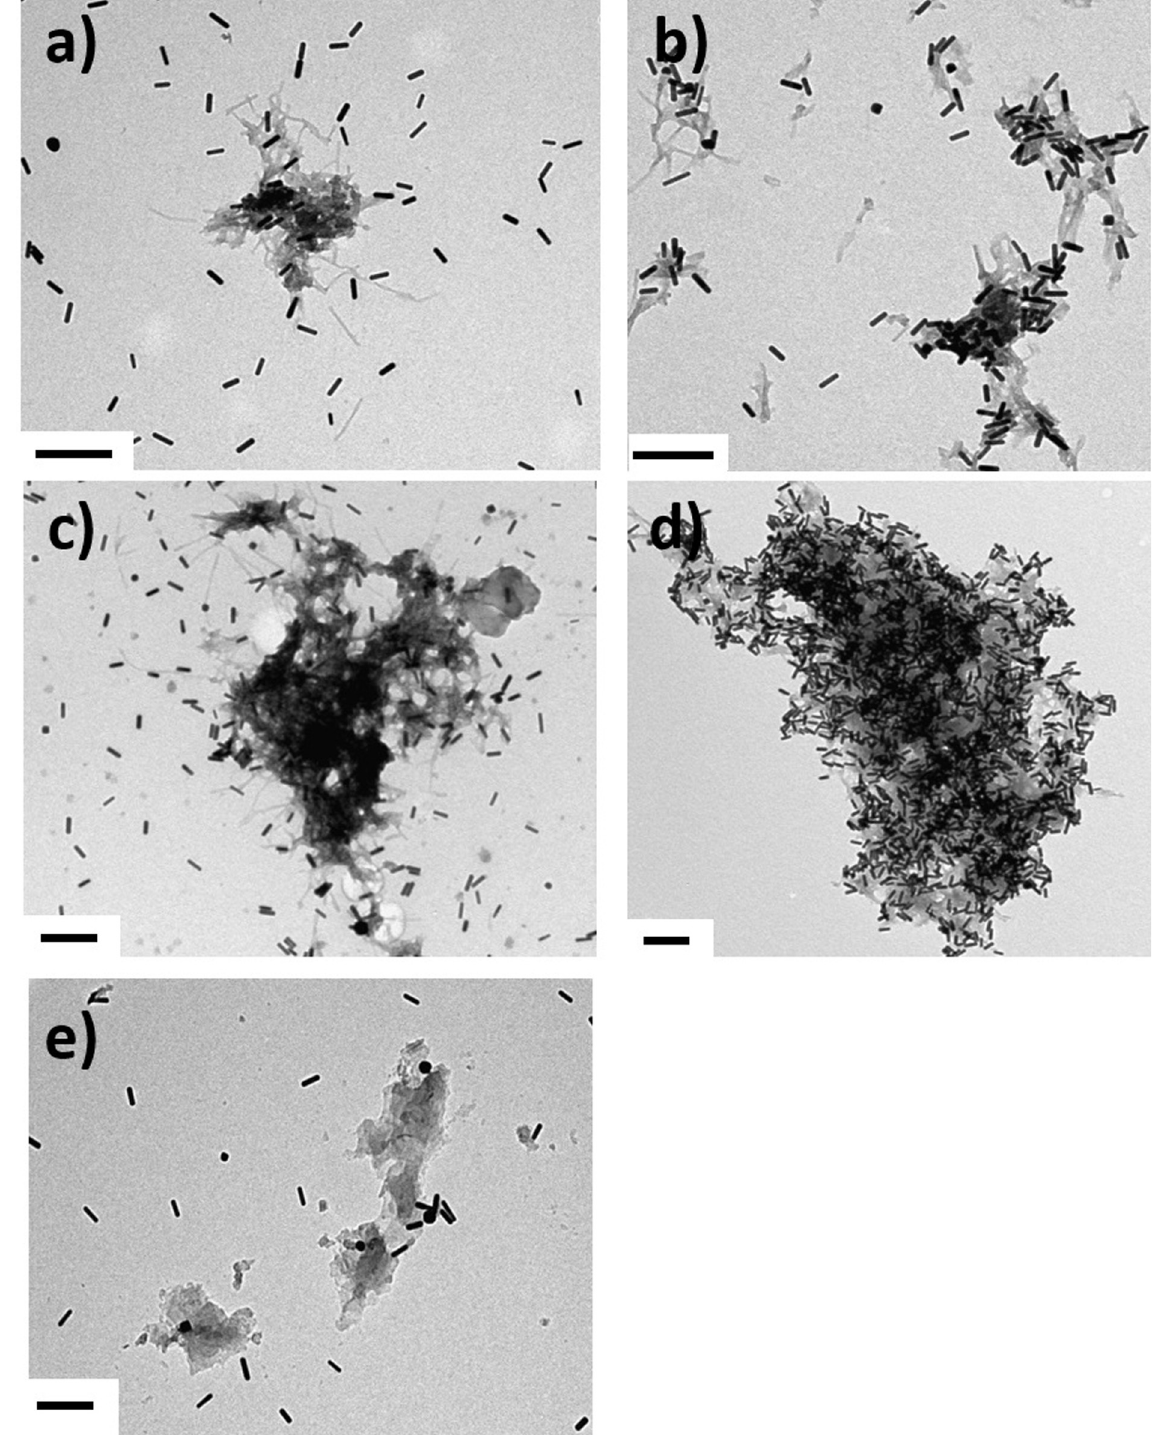
Fig 3. Electron microscopy confirms specific association of Abs-GNRs with A β seeds and fibrils. A β seeds incubated overnight with a) PMA-GNRs and b) Abs-GNRs. A β fibrils incubated overnight with c) PMA-GNRs and d) Abs-GNRs. e) Abs-GNRS incubated overnight with seeds formed from a control amyloidogenic protein medin. Scale bars correspond to 200